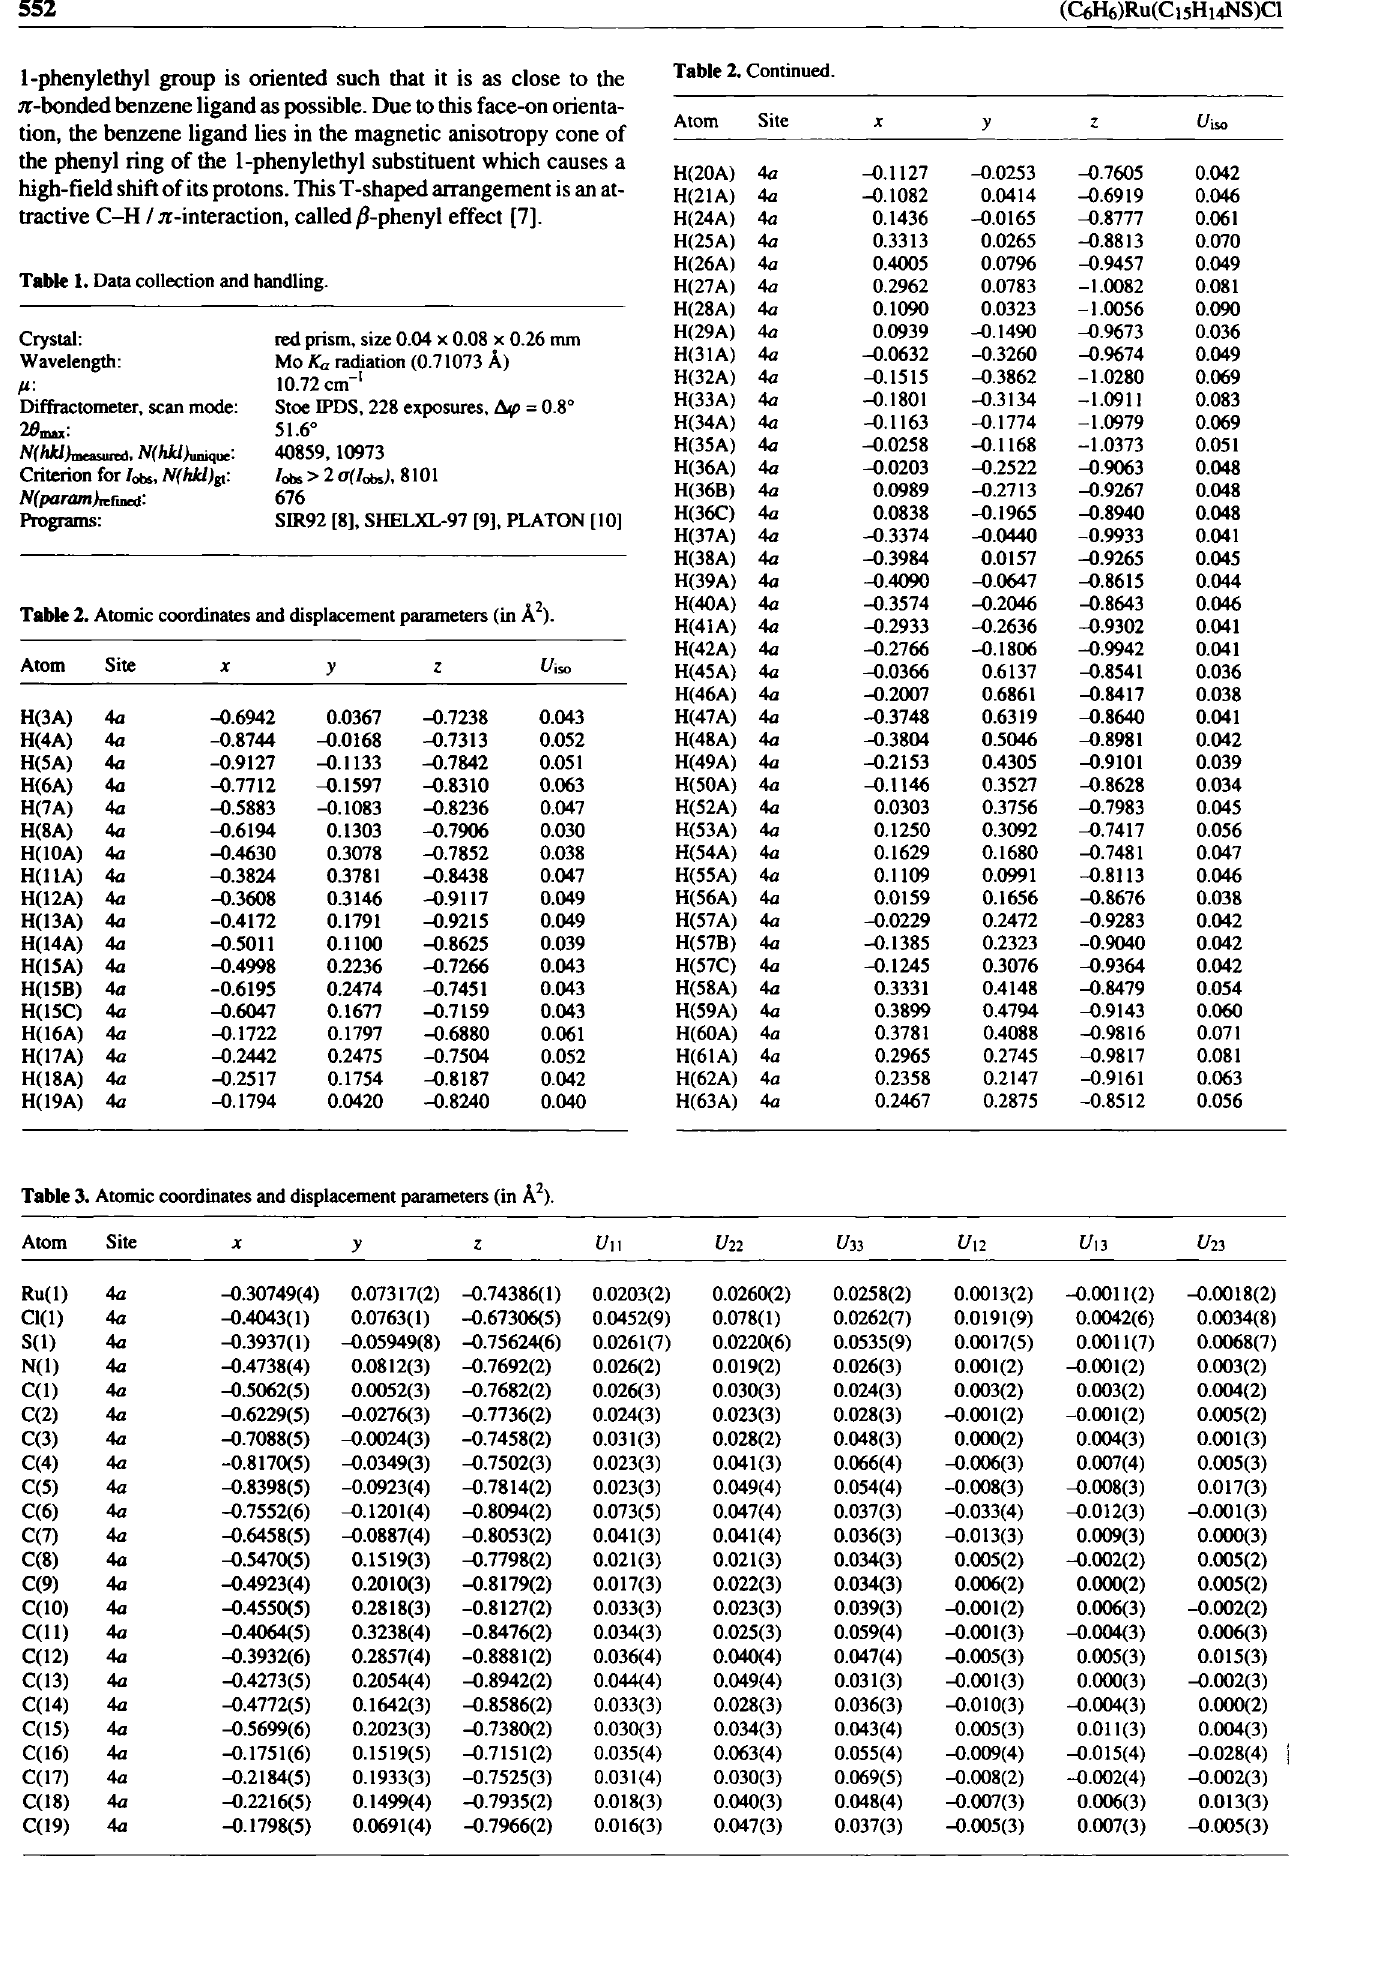
Table 9. Atomic coordinates and displacement parameters (in Â 2